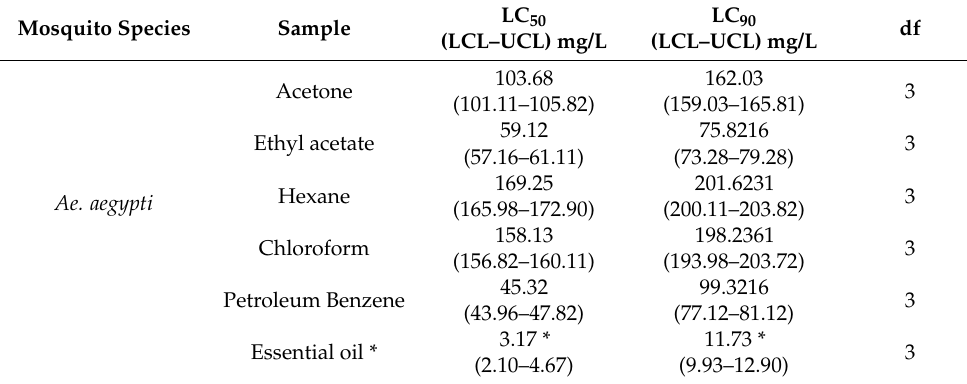
Table 2. Larvicidal activities of A. nilotica seed extracts and essential oil against the fourth instar larvae of Ae. aegypti.